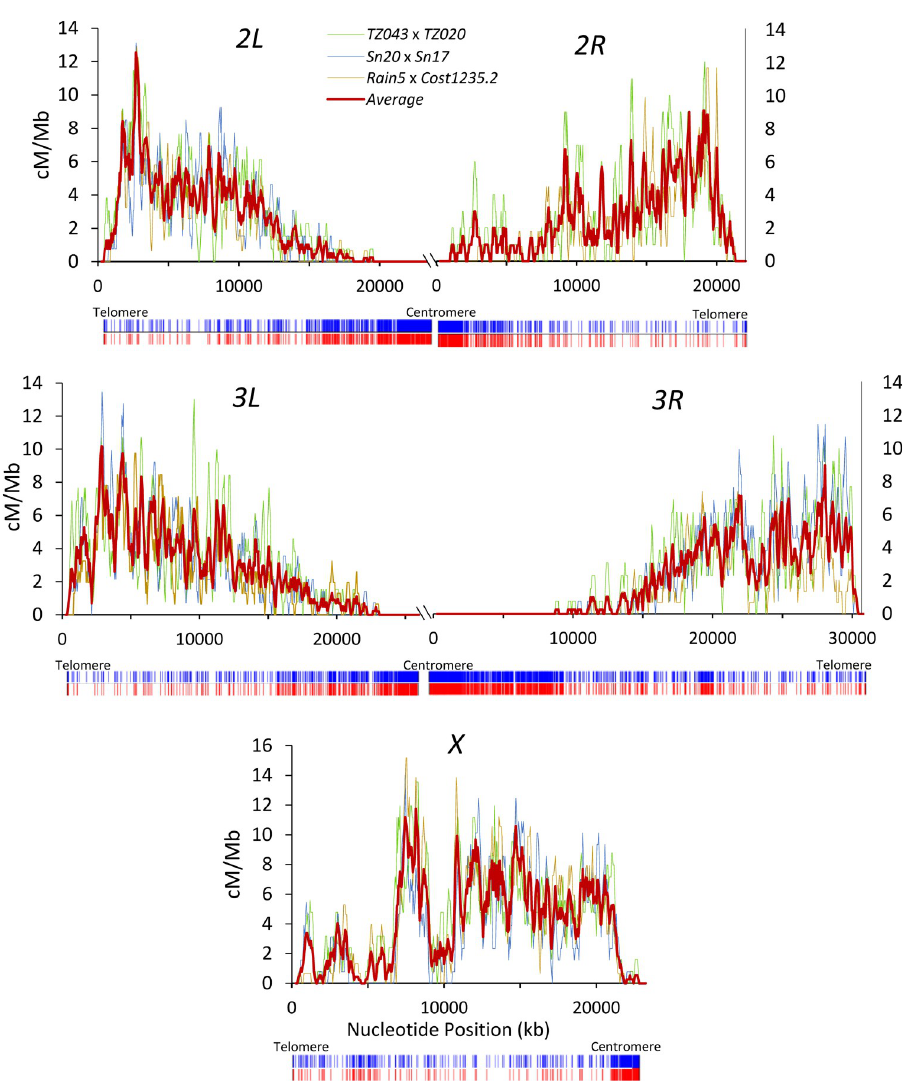
Fig 3. High-resolution crossover maps for D . yakuba . Crossover rates (cM/Mb) are shown along chromosome arms from three different crosses as well as the average (thick red line). Maps are shown for overlapping 250-kb windows with increments of 50 kb. Below each chromosome, vertical blue and red bars indicate the presence of transposable and INE-1 elements, respectively. The scale for the different chromosome arms is equivalent and differences in figure size capture differences in chromosome arm